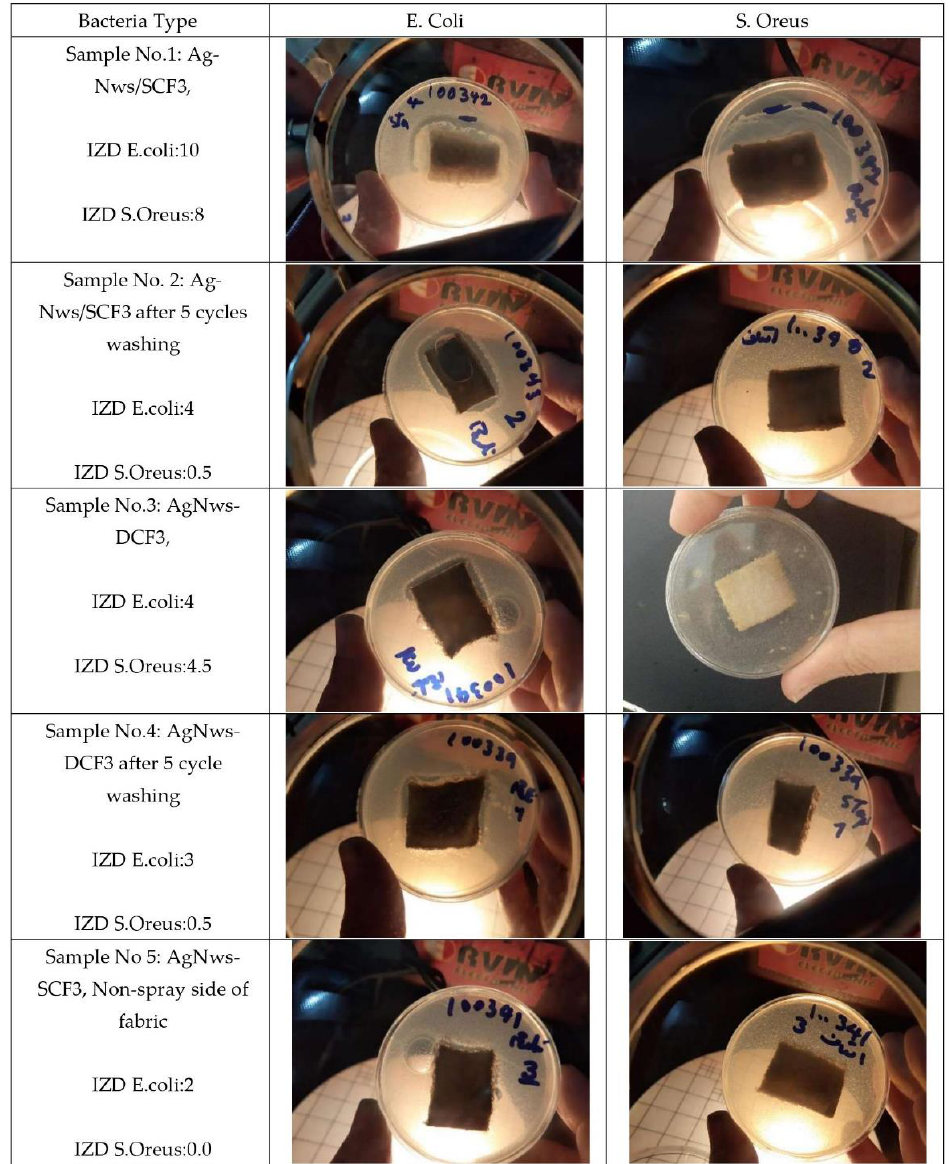
Figure 7. Antibacterial test of samples (1) AgNWs-SCF3, (2) AgNWs-SCF3 after 5 cycles of washing, (3) AgNws-DCF3, (4) AgNws-DCF3 after 5 cycles of washing, (5) AgNWs-SCF3 (non-spray side of fabric). IZD: Inhibition zone diameter.